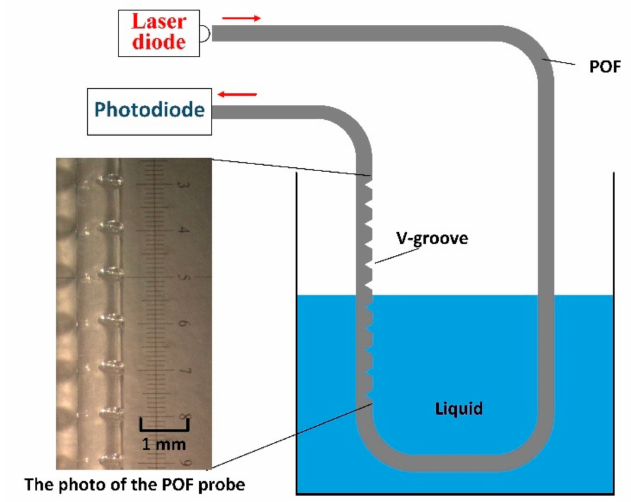
Figure 3. Schematic diagram of the experimental